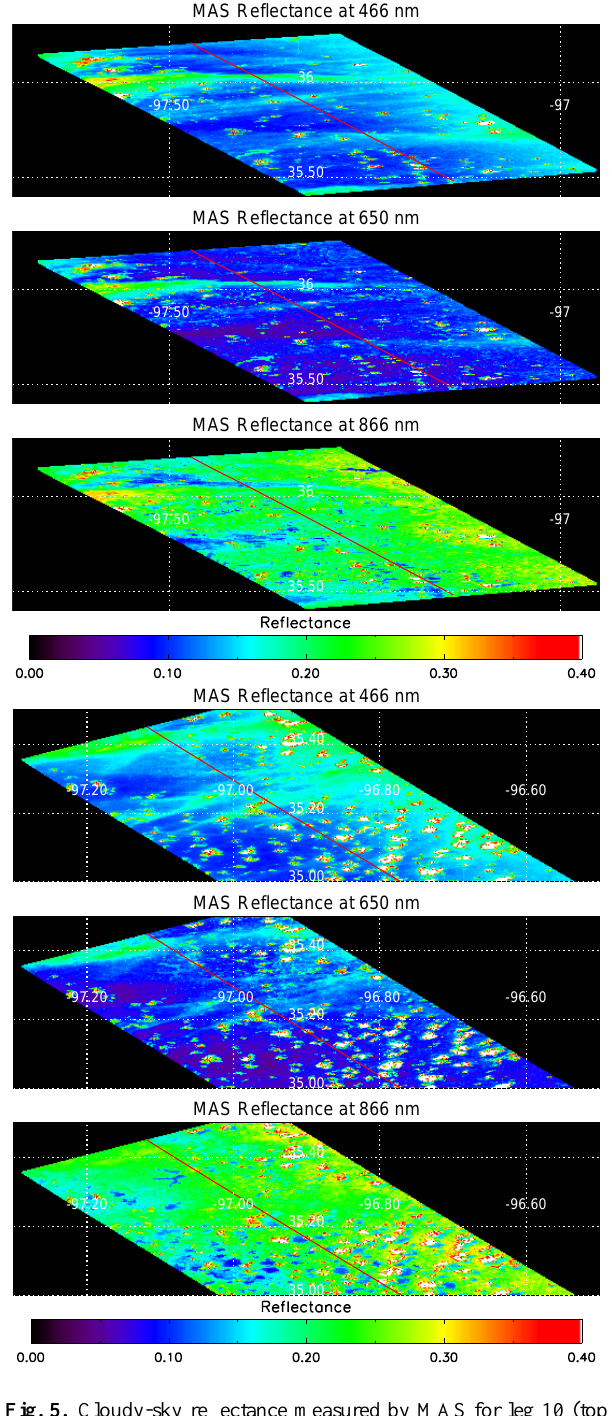
Fig. 5. Cloudy-sky reflectance measured by MAS for leg 10 (top panel) and leg 11 (bottom panel) as function of wavelength: 466nm (top), 650nm (middle) and 866nm (bottom). Solid lines in the middle of these images define tracks of the ER-2 flights during 12 June